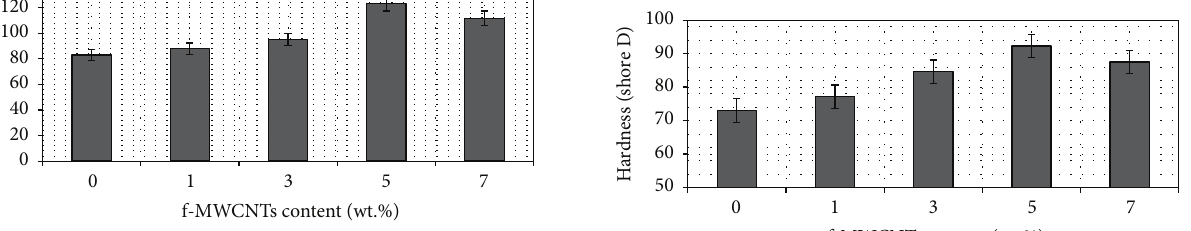
Figure 7: Effect of f-MWCNTs on tensile strength of nanocompos- ites.